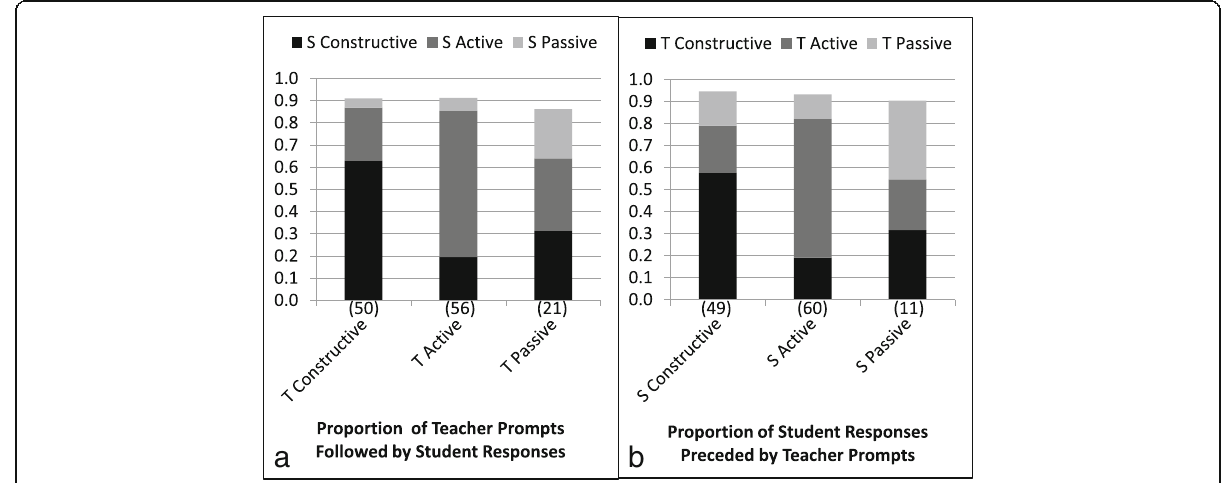
Fig. 4 Proportion of teacher-student exchanges from a teacher perspective and b student perspective (with mean total